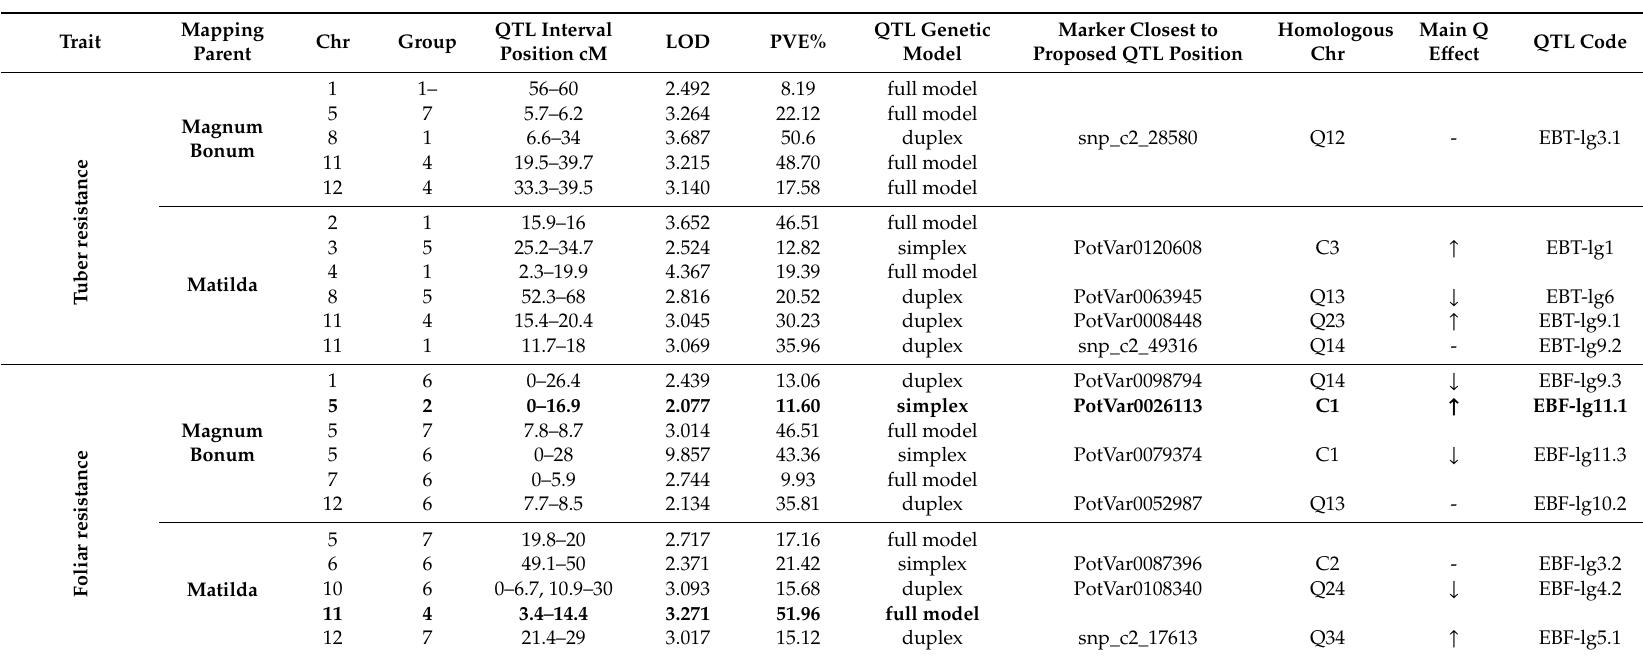
Table 2. Significant quantitative trait loci (QTL) for tuber and foliar resistance to A. solani and defoliation. Chr: Chromosome. Groups 1 to 7 indicate which phenotypic traits the predicted QTL can be linked to. In bold are the QTL for foliar resistance and defoliation that are most likely to be independent from each other, PVE: Phenotypic variation explained. Mapping parent indicates in which of the two parental linkage maps the QTL was found. The position in cM is the area of the linkage group where the genetic signal reached the logarithm of the odds ratio ( LOD) threshold. Main Q e ff ect is estimated as the closest single nucleotide polymorphisms (SNPs) e ff ect on the o ff spring phenotype, only significant e ff ects ( P < 0.05) are included; “–” indicates that no significant e ff ect was detected in the o ff spring, greater ( ↑ ) and lower ( ↓ ) trait values were defined as the mean phenotype of the o ff spring compared to parent with corresponding genotype. The QTL code corresponds to the Supplementary Figures S2 and S3, containing linkage groups from the two parental linkage maps. The QTL code name contains information on the phenotypic trait the loci influences and which linkage group the loci was detected